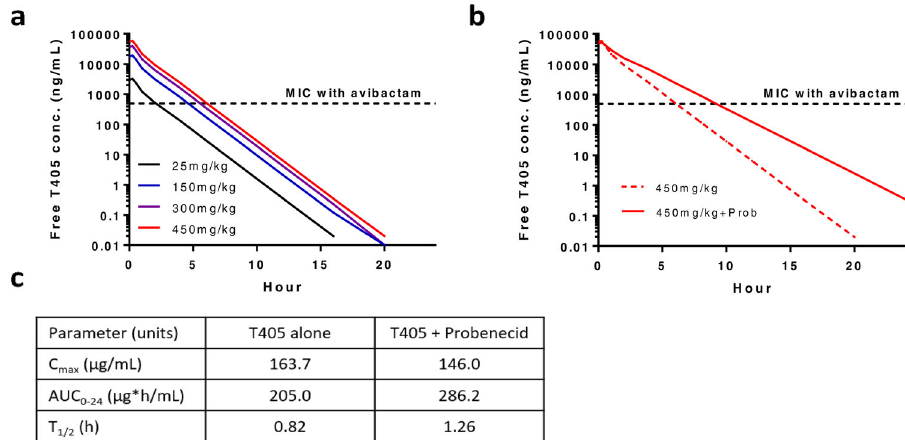
Fig. 2 Simulated single-dose plasma-free T405 concentration – time pro fi les in BALB/c mice. a Escalating doses of T405 administered alone. b 450mg/kg dose of T405 administered alone and in combination with probenecid. c Single-dose plasma PK parameters for total T405 concentration in mice after subcutaneous injection of 25mg/kg ( n = 3 mice per time point per